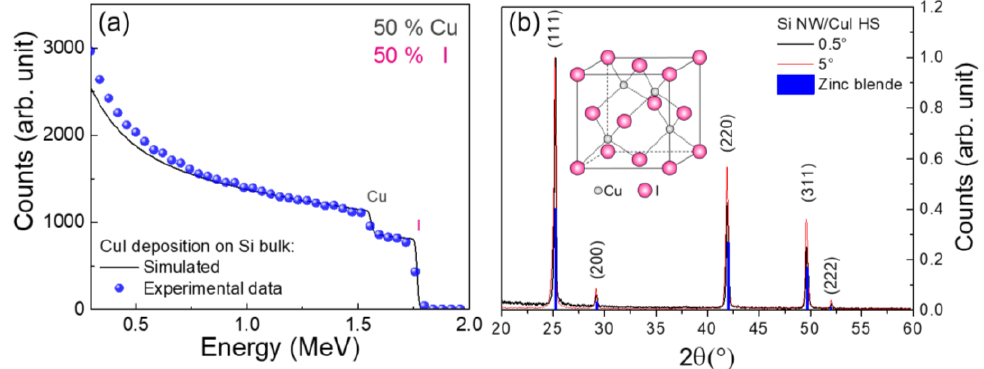
Figure 4. ( a ) Rutherford backscattering spectrometry of a CuI layer deposited onto a Si bulk substrate with CBD and spray coating. Experimental data (blue dots) were fitted with a simulated layer with composition Cu 0.5 I 0.5 obtained from SimNRA (black line). ( b ) XRD spectra for the Si NWs/CuI heterostructure obtained at 0.5° (black line) and 5° (red line) compared to the diffraction peaks associated to the CuI zinc blend structure reported from database (blue lines). The inset shows a scheme of γ -CuI zinc blende structure.